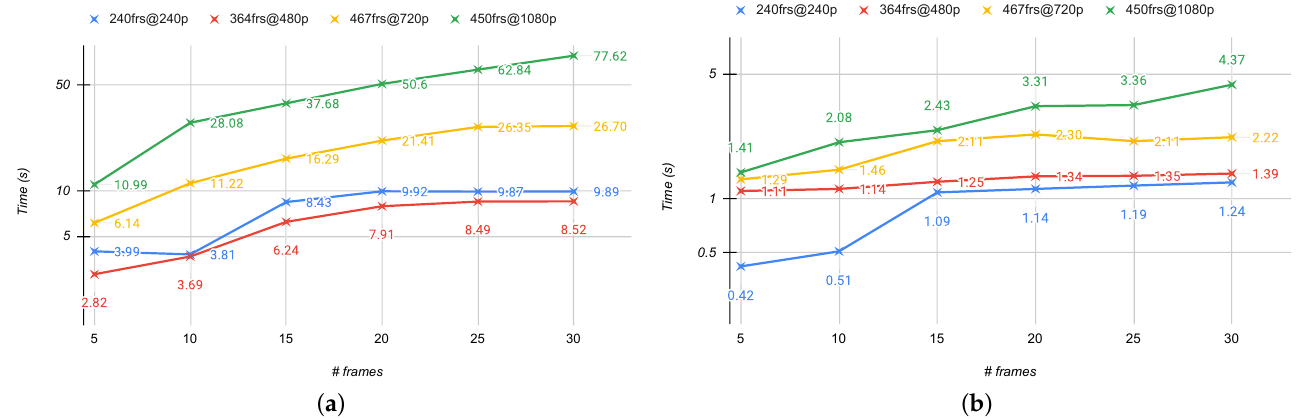
Figure 9. Computation time comparison in seconds for four videos selected from the considered databases with respect to the number of frames sampled. ( a ) The time in CPU; ( b ) the time in GPU. {xxx}frs@{yyy}p indicates the video frame length and the resolution, respectively.